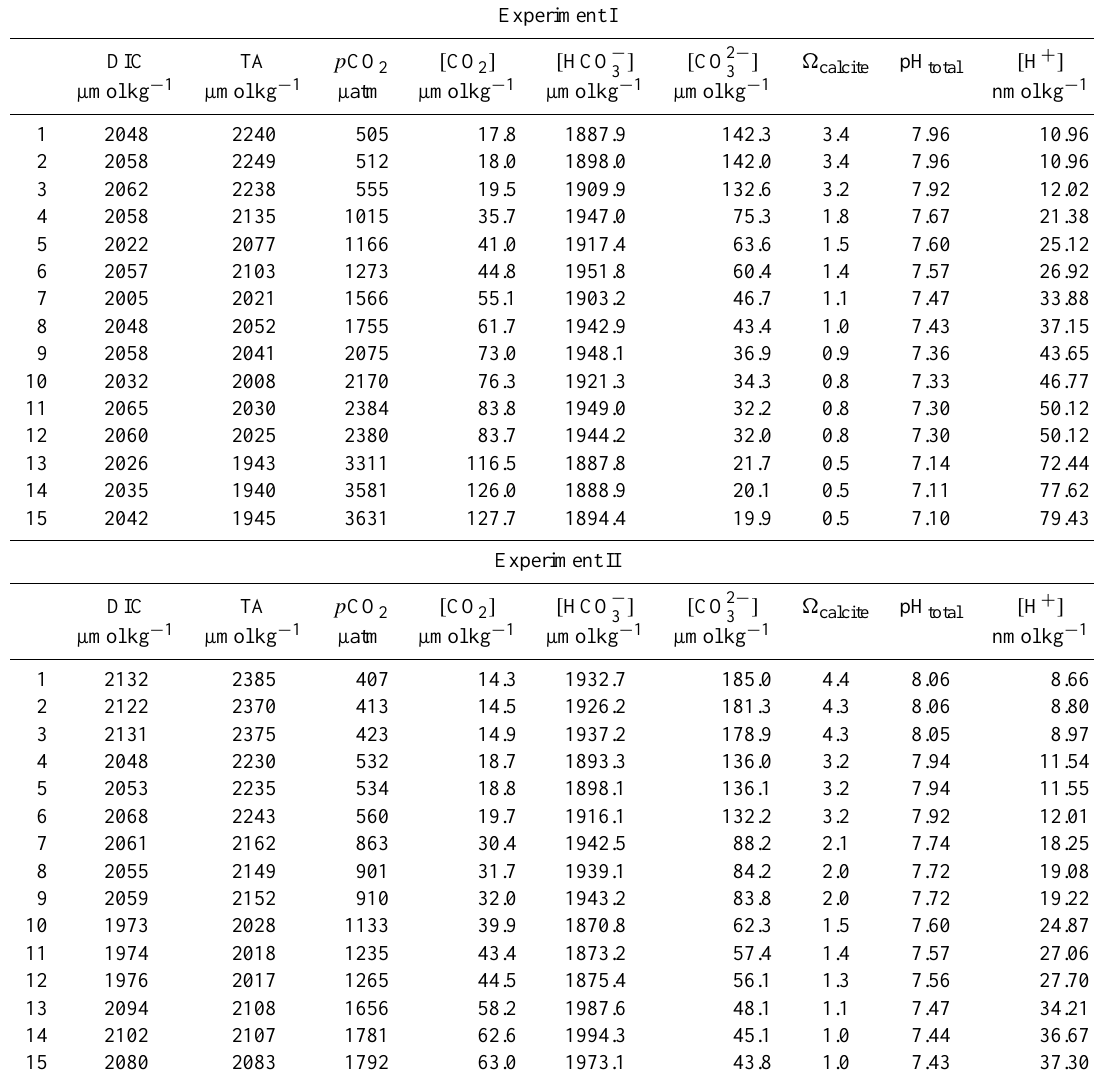
Table 1. Carbon chemistry speciation for experiment I and II, calculated as the mean of start and end values of measured DIC and TA. See materials and methods for details. It is noted that the higher variability of DIC concentrations in the second compared to the first experiment is due to inaccuracies in artificial seawater preparation and slightly higher variability in final cell